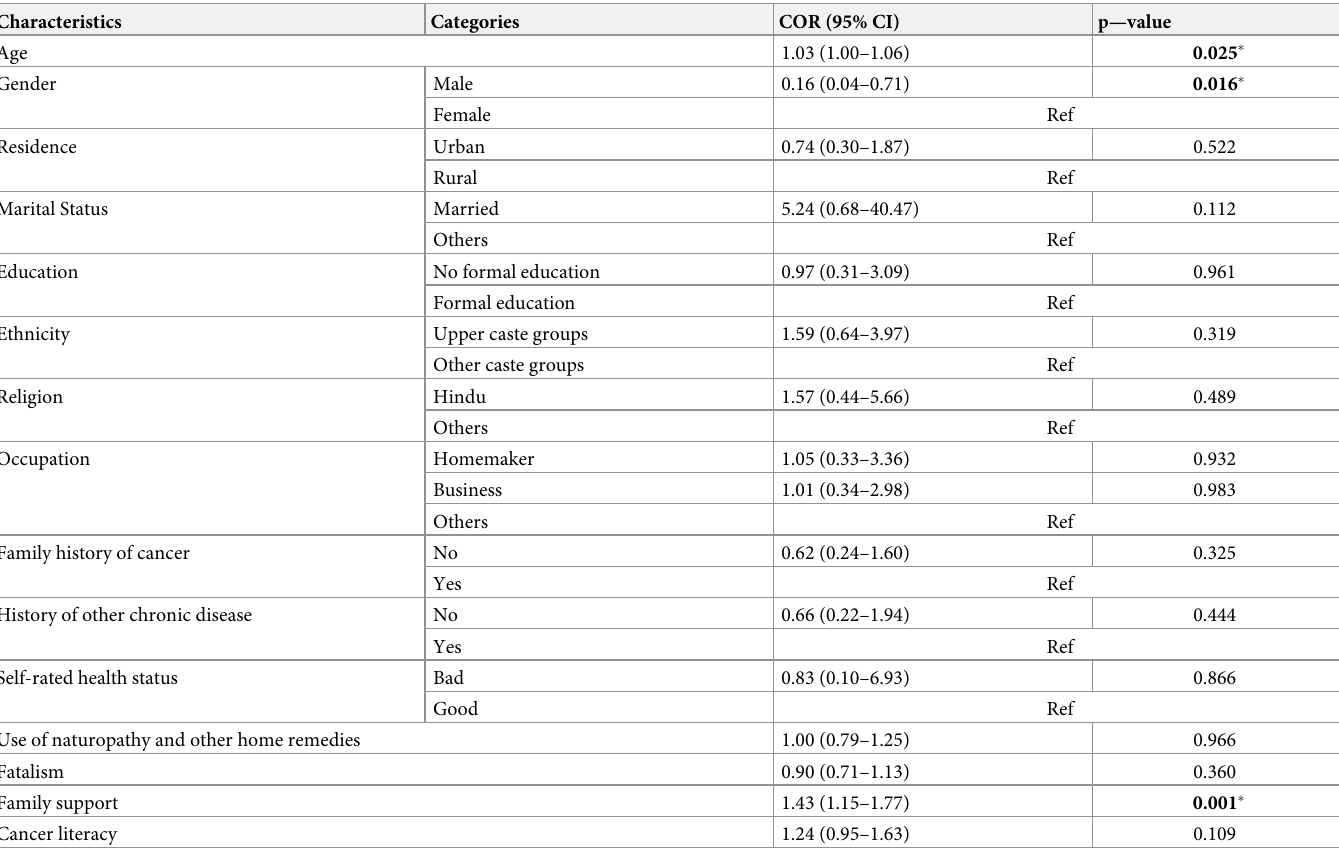
Table 5. Simple logistic regression analysis of socio-demographic characteristics, need, pre-disposing and enabling factors; and cancer literacy scores with cancer screening behaviour among the study participants (n = 180). Characteristics